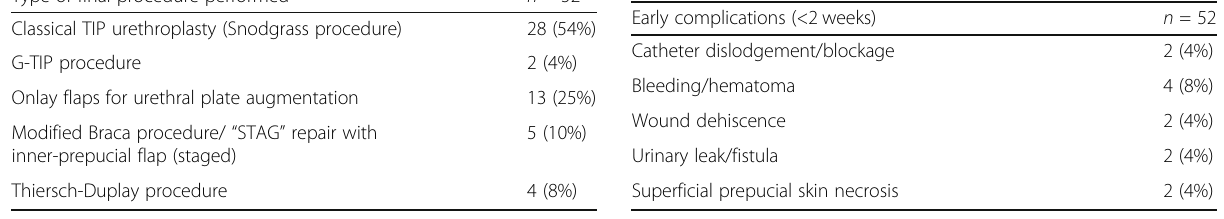
Table 8 Early complications after surgery (at or before 2 weeks